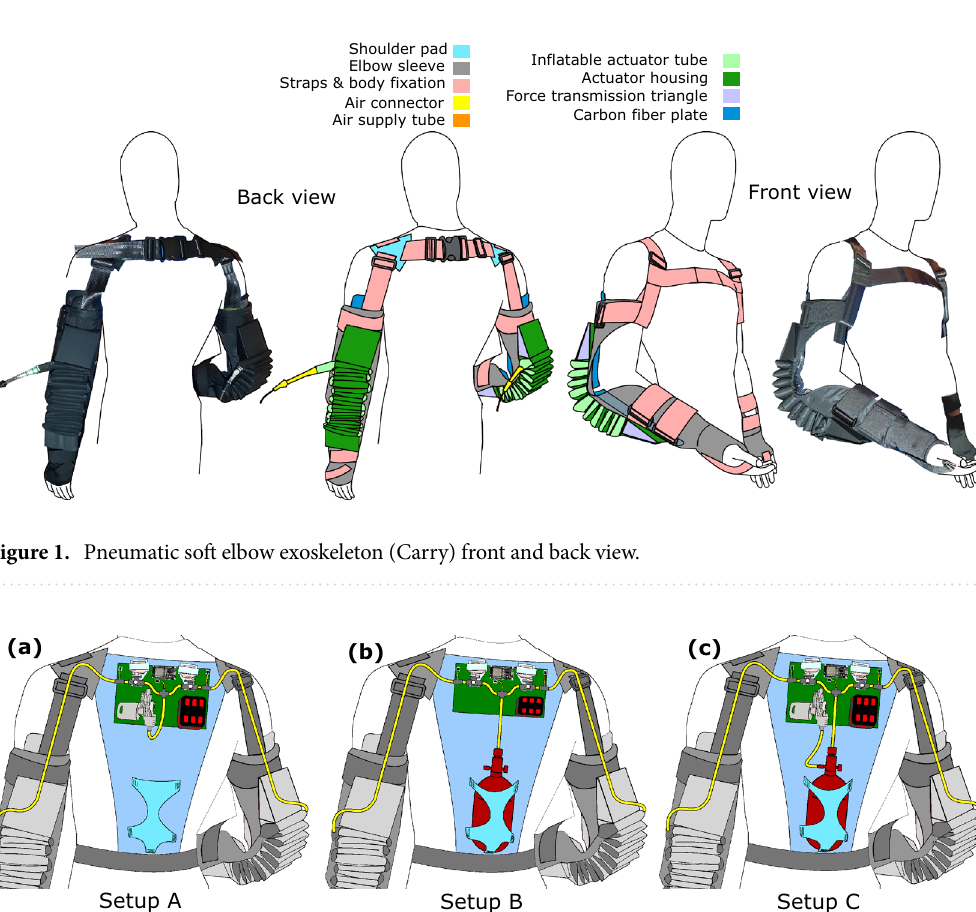
Figure 2. Possible future autonomous Carry setups. ( a ) Setup A is powered by a compressor, ( b ) Setup B by a pressure tank, and ( c ) Setup C by a compressor and a pressure